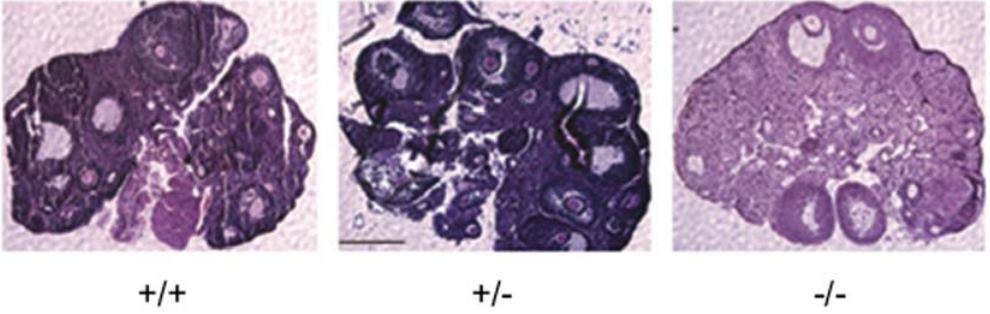
Figure 4. Analysis of Coil 2 / 2 ovaries. Ovaries were removed from P42, sexually mature, females and cross sections were H & E stained. No obvious morphological abnormalities were detected among the genotypes. The parallel lines observed are artifacts from preparation of the tissue samples. The scale bar in the center panel is 2 mm.